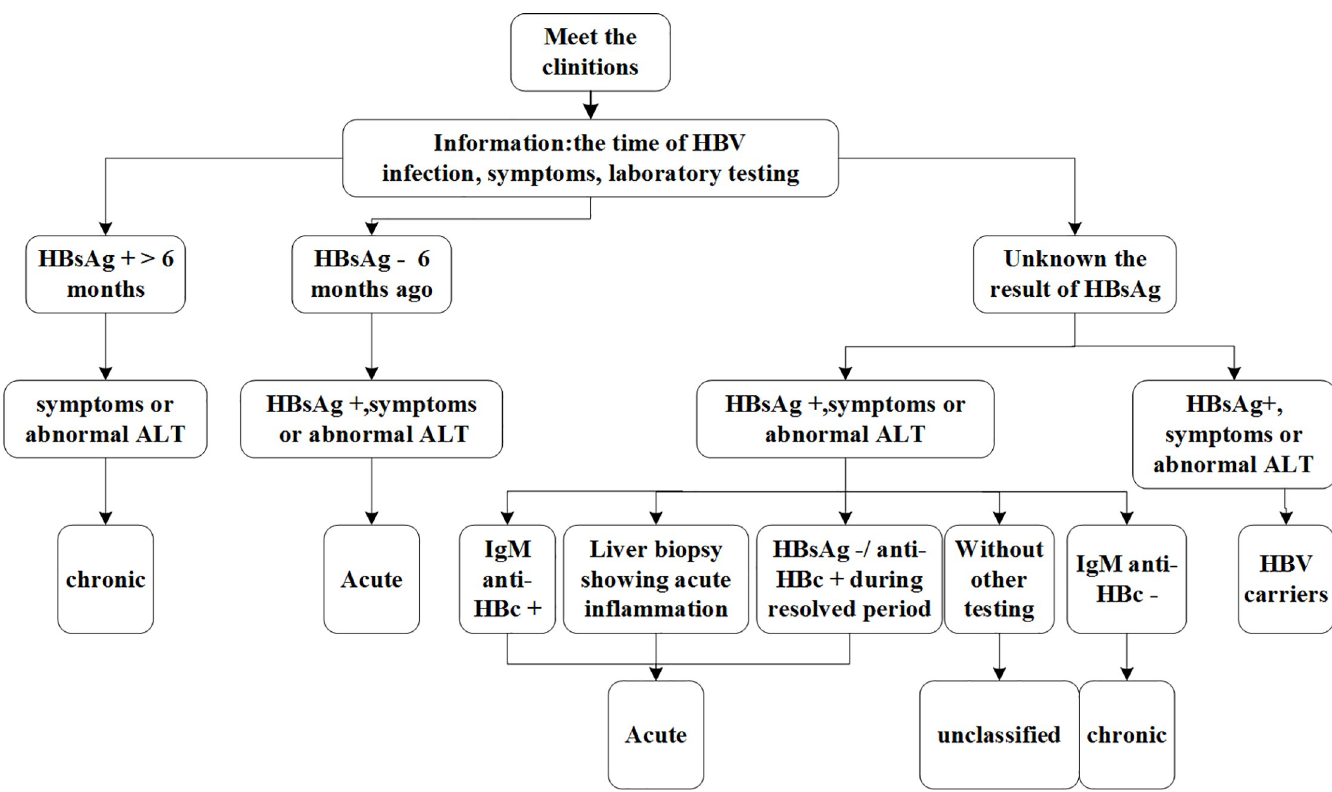
Fig 2. Standardized diagnosis and reporting process in surveillance point, China. Fig 2 represents standardized the diagnostic and reporting procedures for clinicians based on national diagnostic criteria. This flowchart reminds clinicians how to diagnose acute and chronic hepatitis B.